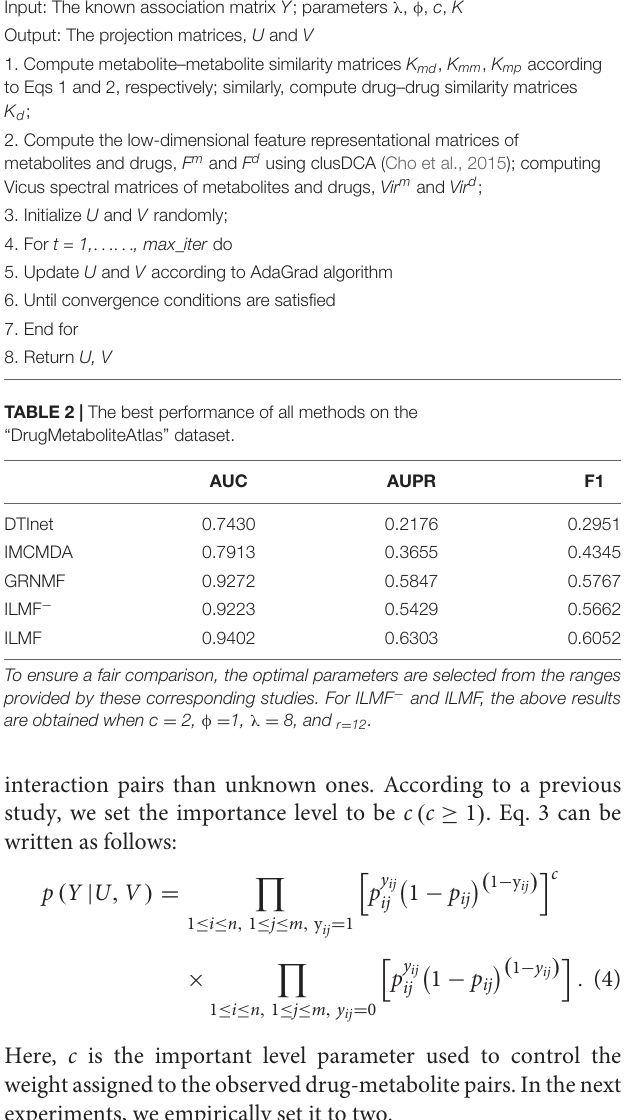
TABLE 1 | The pseudocode of the ILMF algorithm.